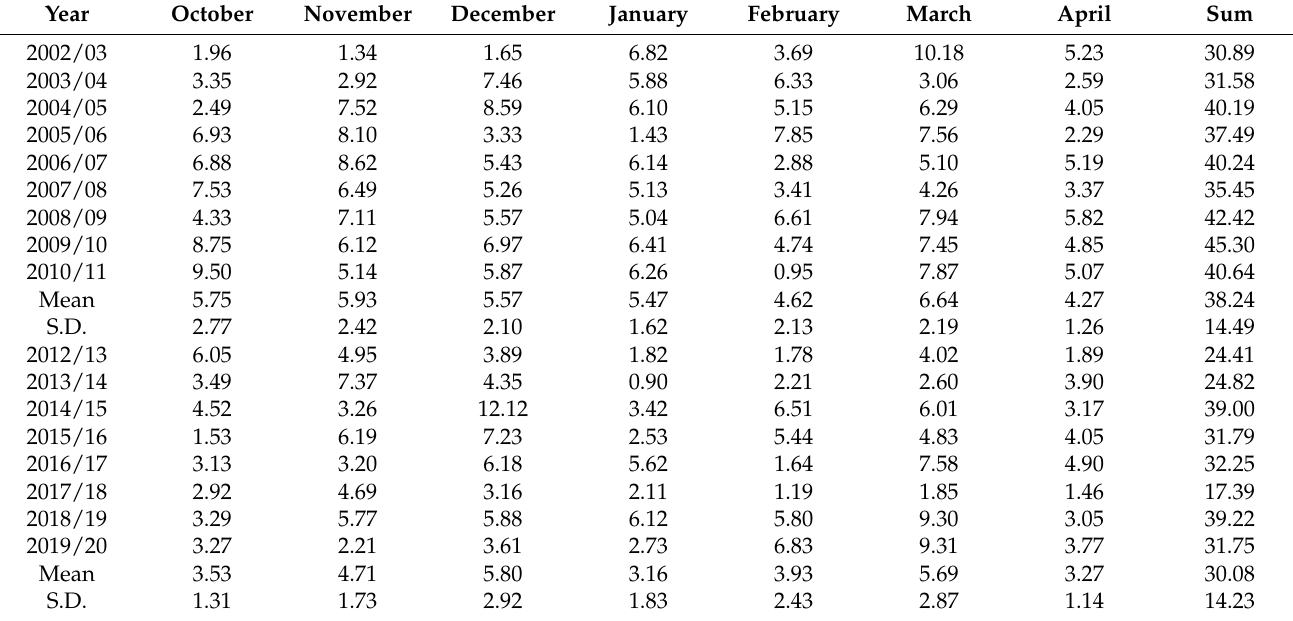
Table 2. Monthly MYI area export through the FS (10 4 km 2